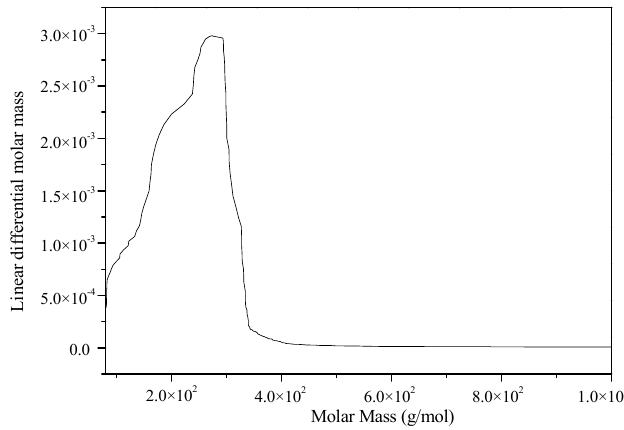
Figure 3. Overlaid differential molar mass of HBP ‐